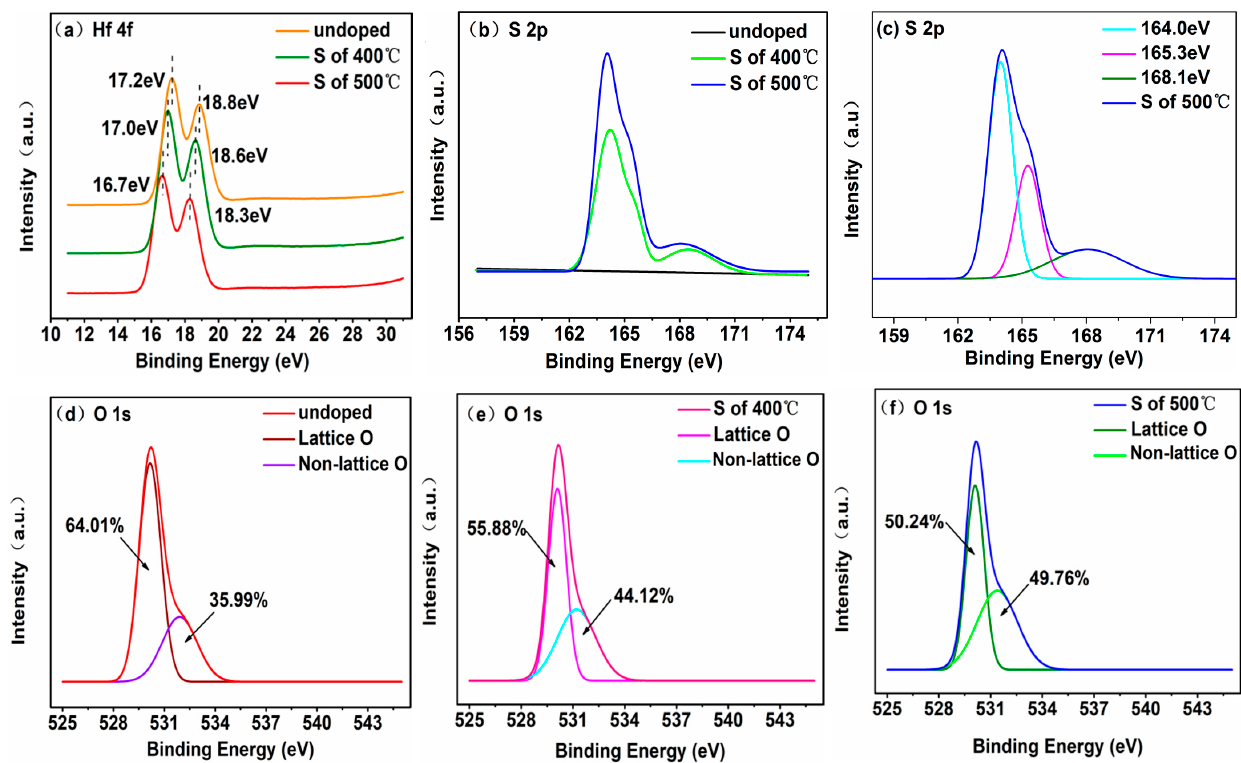
Figure 7. XPS spectra of ( a ) Hf 4f, ( b , c ) S 2p, ( d – f ) O 1s for the undoped and S-doped HfOx films.